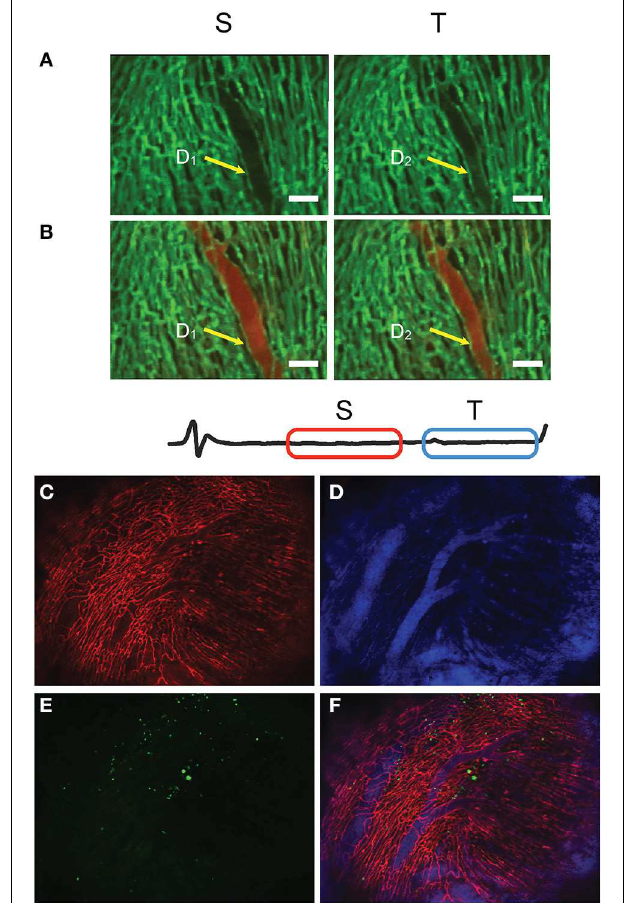
FIGURE 14 | Time-lapse fluorescence imaging of heart perfusion using a vascular pool imaging agent injected via tail vain. Frames S and T are taken at two different time-gating windows within the ECG, corresponding to two distinct phases of the cardiac cycle. (A) Images taken before perfusion. (B) Images taken after perfusion. Changes in the vessel diameter are evident for the two phases. Green: fluorescent lectin staining of capillaries; red: fluorescent signal from the vascular pool agent Angiosense-680. (C–F) Large field of view images obtained with SSM of a heart which sustained an ischemia reperfusion injury before being injected with GFP-expressing cells, freshly isolated from the bone marrow of a donor mice. (C) Red represents the fluorescence lectin signal from stained capillaries; (D) blue the fluorescence signal produced by the blood pool imaging agent Angiosense-680; (E) green the GFP-expressing cells; (F) fusion of three images. Adapted from Lee et al.